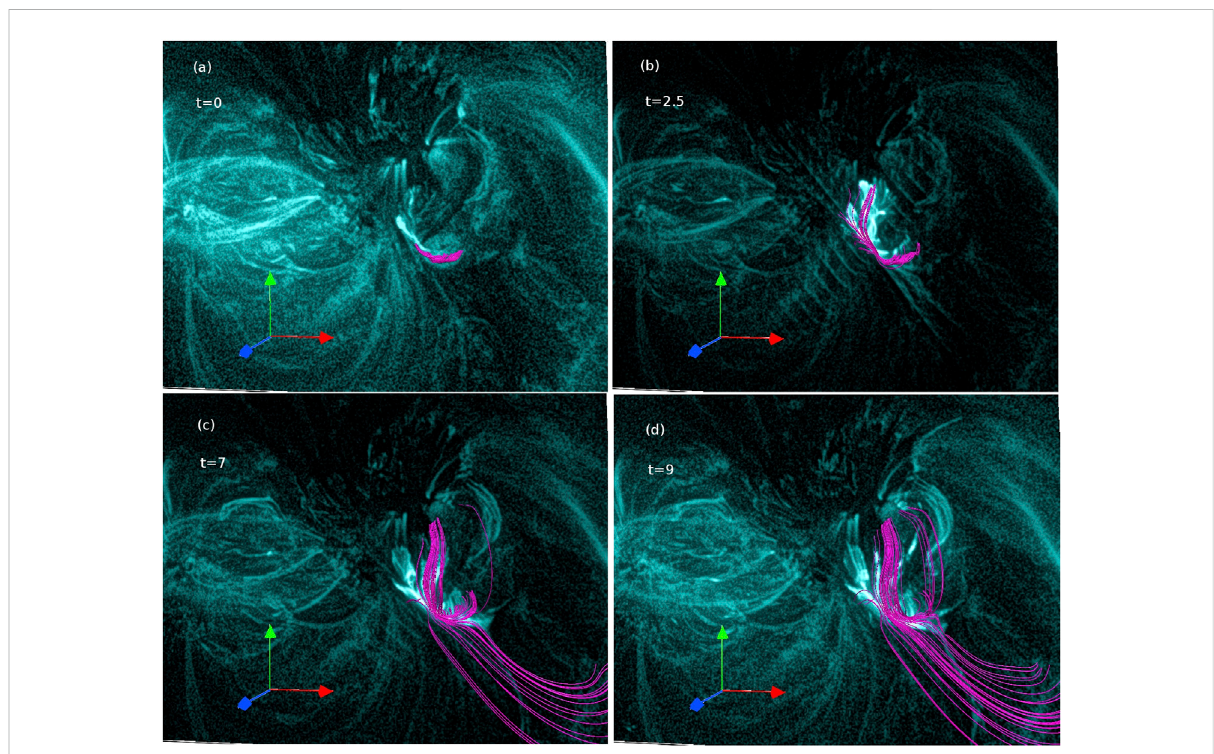
FIGURE 6 Evolution of the magenta-colored fl ux rope co-relating the brightenings in 131 Å [panel (A) ]. The evolution is overplotted with the co-current 131 Å images. Notable is the similar bifurcations ofthe rope and brightenings in 131 Å [panel (B) ]. Panels (C and D) indicate the rise of the rope and its reconnection at the 3D null. Also see Supplementary Video S1 for a high-cadence evolution of the